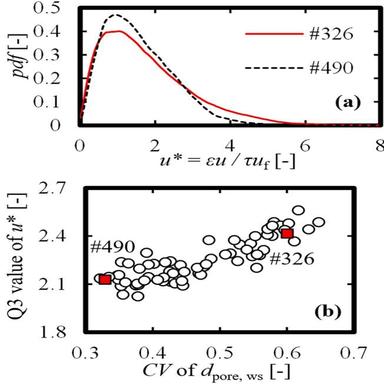
(a) Normalized velocity distribution of #490 and #326. The vertical axis represents the probability density, and the horizontal axis represents the velocity divided by the interstitial velocity. The curves were obtained by kernel fitting implemented on MATLB®, as shown in Fig. S5. (b) Relationship between Q3 of u\ and CV of dpore, ws.